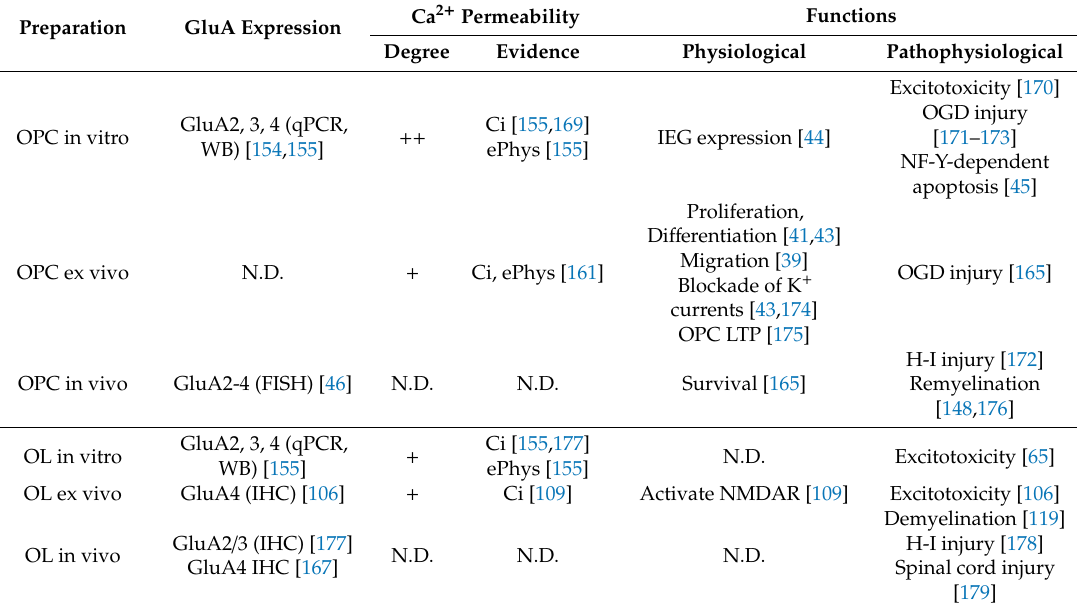
Table 2. Summary of AMPAR expression and functions in